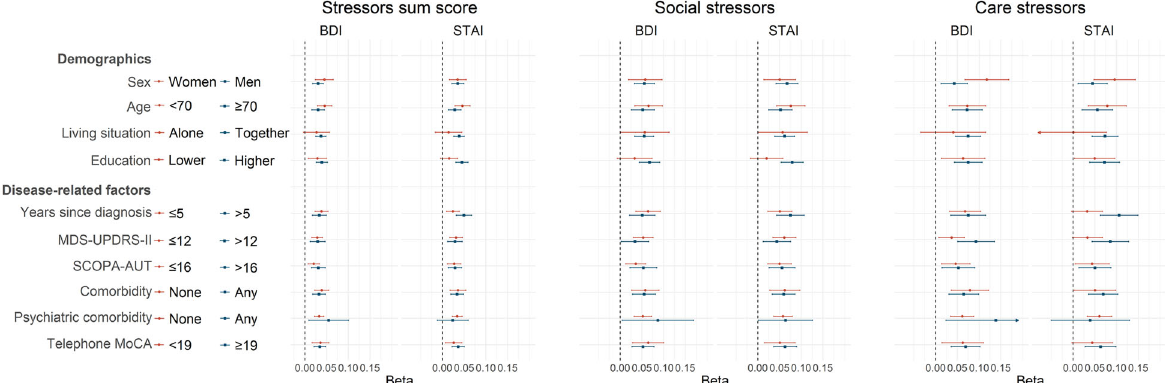
Fig. 2 Association between sum scores of COVID-19 related stressors and depressive and anxiety symptoms strati fi ed by demographics and disease-related factors. Points represent the regression coef fi cients of the linear models and bars the 95% con fi dence intervals. The BDI and STAI were standardized in order to make the estimates comparable. Models were adjusted for sex, age, disease duration, presence of comorbidities, education, living situation, region and date. The strati fi cation variable was excluded for adjustments. Higher education